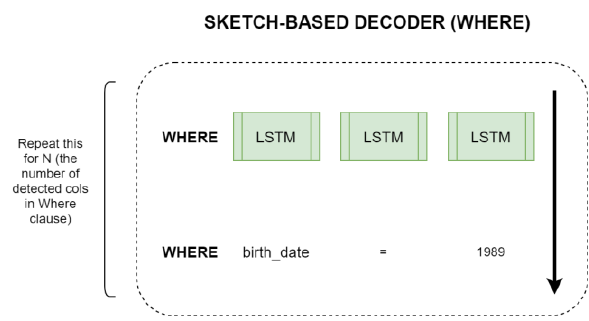
Figure.5. The Sketch-based decoder – where clause.